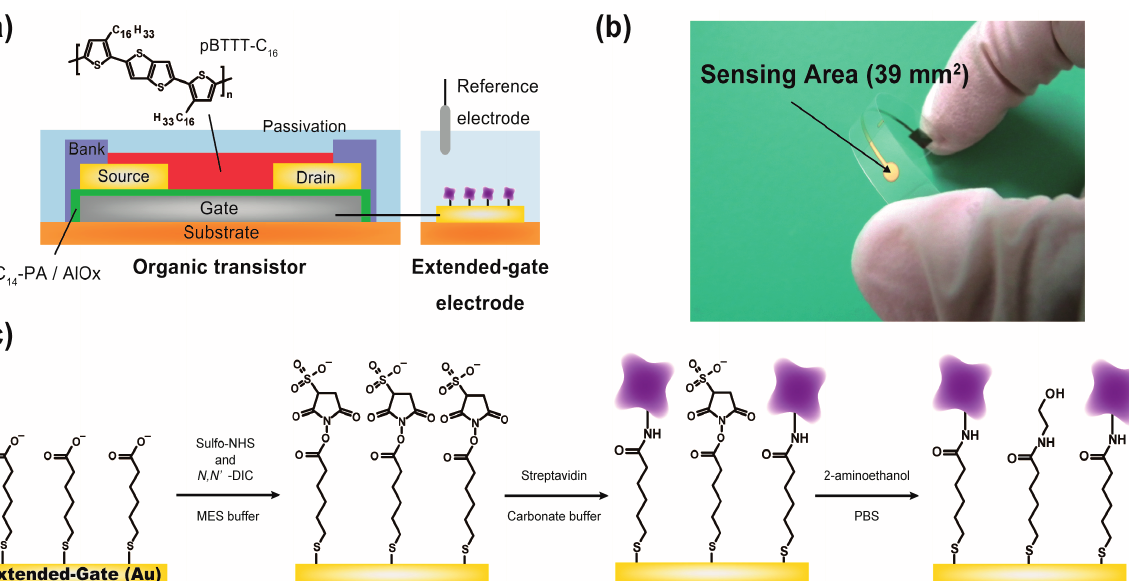
Figure 1. ( a ) Schematic structure of the extended-gate-type organic transistor; ( b ) a photograph of the sensing part ( i.e. , the extended-gate electrode); and ( c ) the reaction scheme for the immobilization of streptavidin on the surface of the extended-gate electrode. Unreacted N -hydroxysulfosuccinimide (sulfo-NHS) esters are treated with